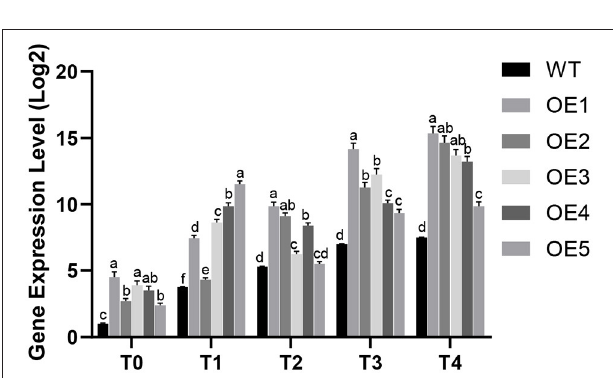
FIGURE 5 | The expression level analysis of PdPapWRKY28 in putative transformants. WT: wild type Populus davidiana × P. alba var. pyramidalis Louche (Pdpap). OE1–OE5: transformant lines. T0–T4: infection time was 0, 6, 12, 24, and 48h. Error bars represented the standard deviation of the three independent replicates. Significant differences ( P < 0.05) were indicated by different lowercase